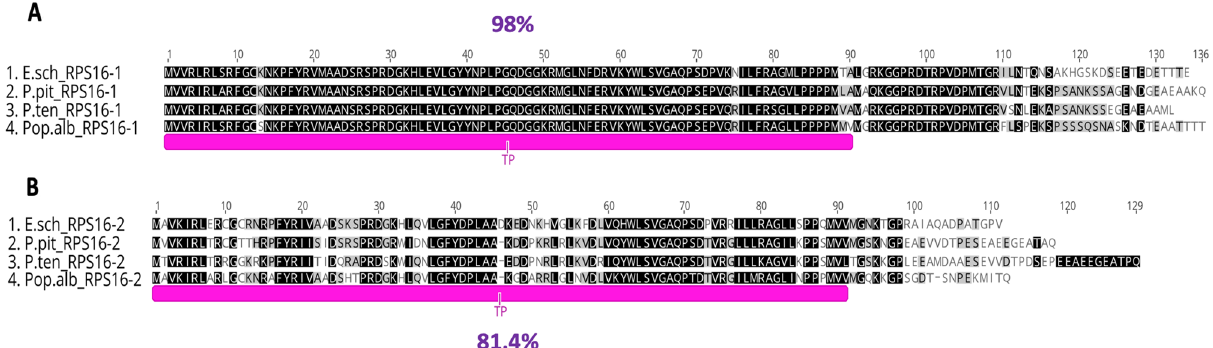
Figure 4. ( A ) Alignment of the amino acid sequences of nuclear RPS16-1 of Euphorbia schimperi, Populus alba (RPS16-1: BAG49074.1) , Passiflora pittieri ; (RPS16-1: QKY65183.1), and P. tenuiloba ; (RPS16-1: QKY65187.1). ( B ) Alignment of the amino acid sequences of nuclear RPS16-2 of Euphorbia schimperi, Populus alba (RPS16- 2: BAG49075.1) , Passiflora pittieri ; (RPS16-2: QKY65185.1), and P. tenuiloba ; (RPS16-2: QKY65184.1). Pink annotation indicates plastid transit peptide (TP) predicted in Populus alba (Ueda et al. 11 ). Alignment of the upstream sequences of RPS16-1 and RPS16-2 of E . schimperi to the transit peptides of RPS16-1 and RPS16-2 of Passiflora ( P. pittieri and P . tenuiloba ) and Populus alba resulted in aa identities of 98 and 81.4%, respectively. Gaps are indicated by dashes.